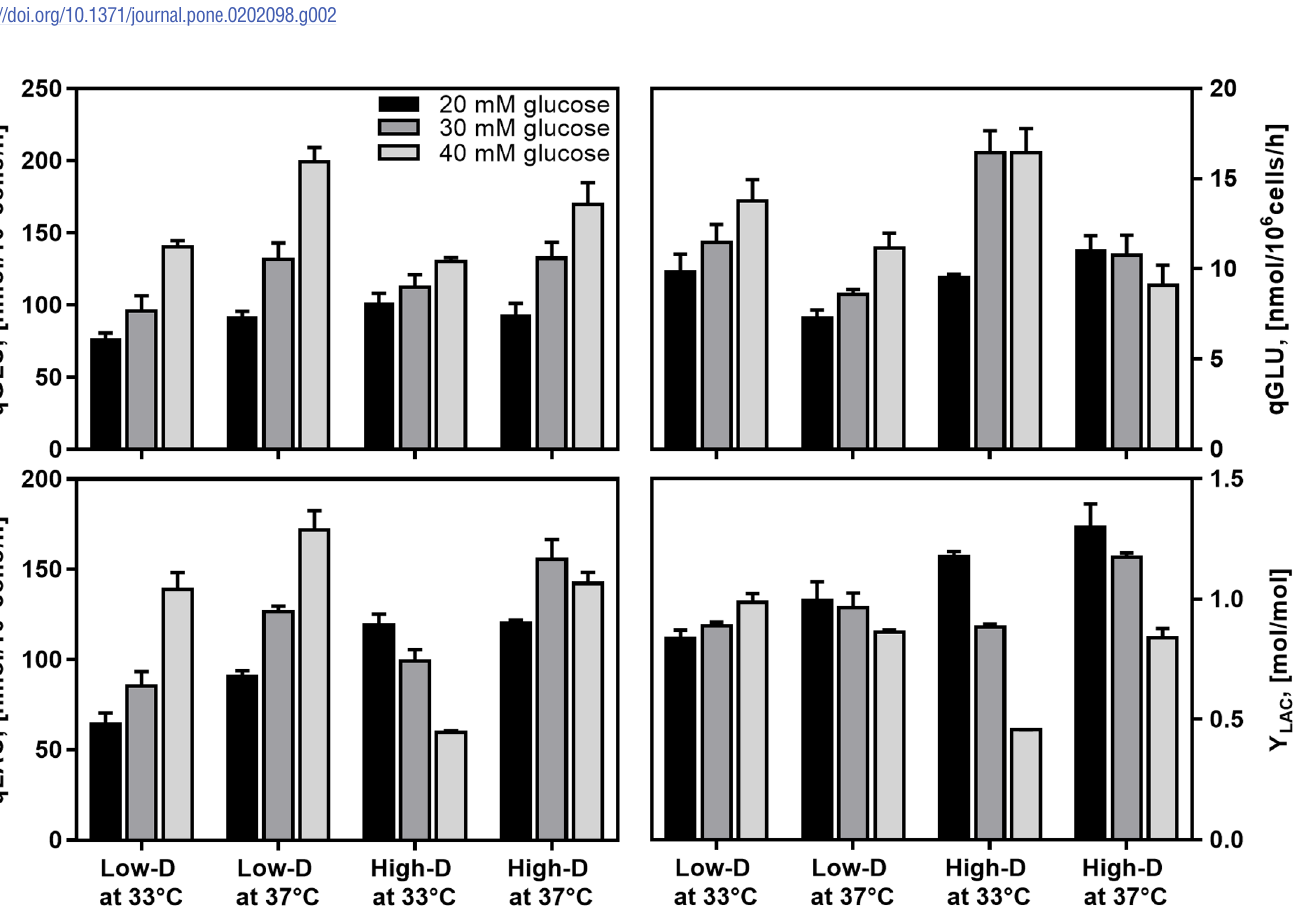
Fig 3. Impact of dilution rate, culture temperature and feed glucose concentration on glucose, glutamate and lactate metabolism in CHO cell chemostat cultures at steady state. ( Black ) 20 mM glucose; ( Dark grey ) 30 mM glucose; ( Light grey ) 40 mM glucose.